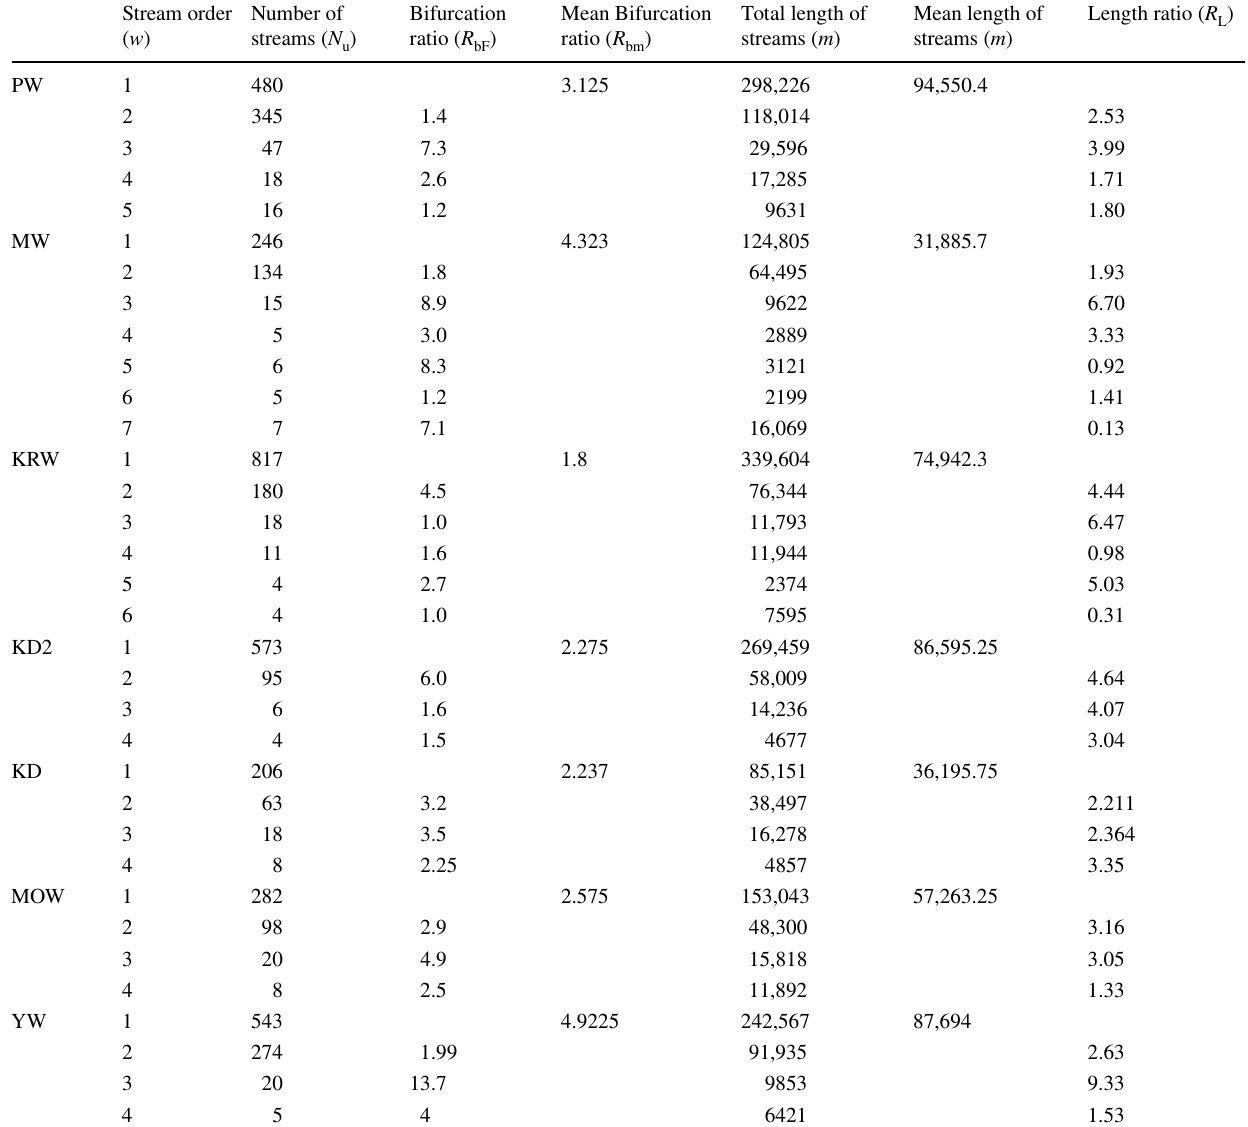
Table 2 Linear aspect of the Vaniyar sub basin Stream order Number of ( w ) streams ( N u